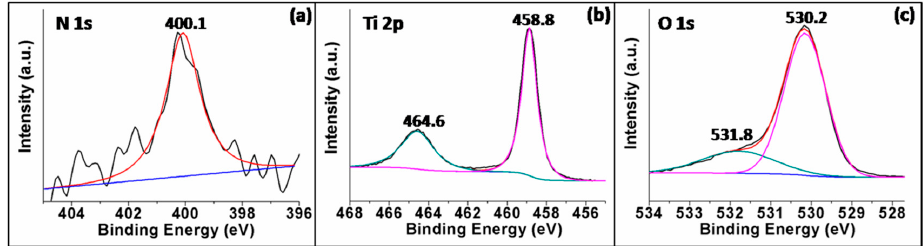
Figure 3. X ‐ ray photoelectron spectroscopy (XPS) spectra of ( a ) N 1s, ( b ) Ti 2p, ( c ) O 1s region for NA ‐ 165.